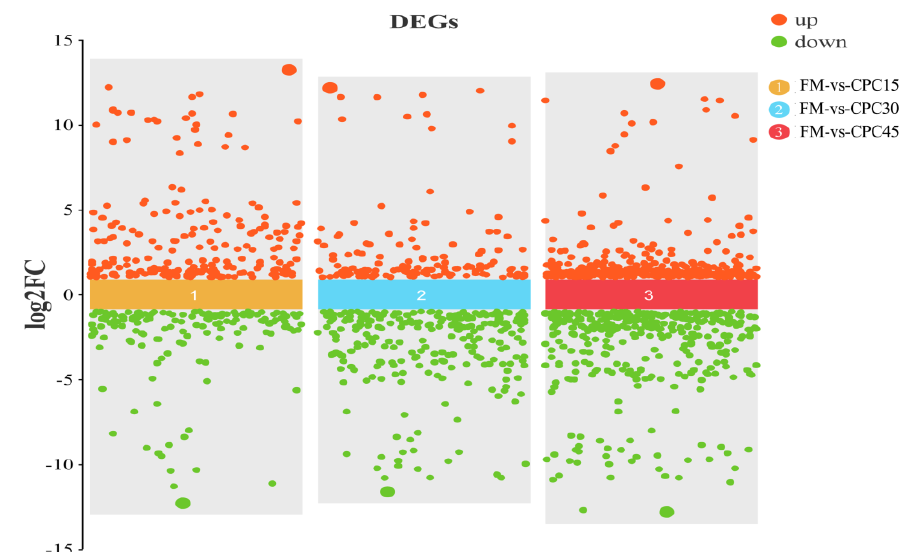
Figure 2. Differentially expressed genes (DEGs) between L. vannamei containing CPC diet and FM